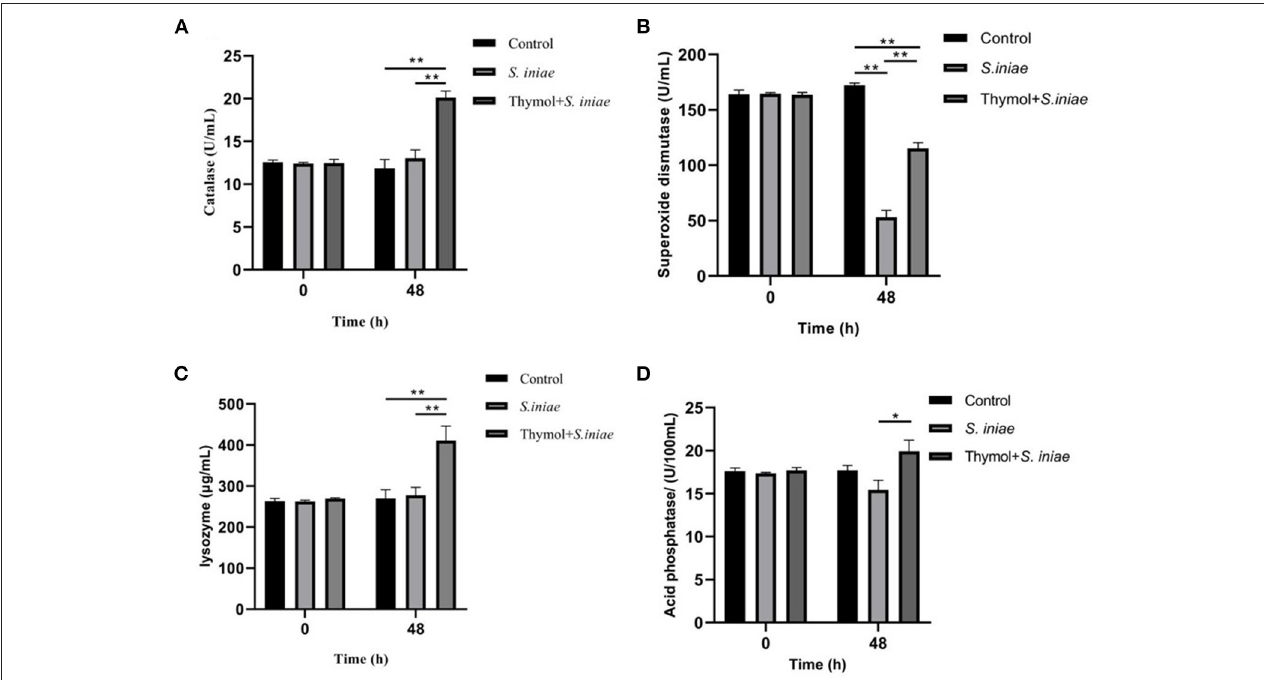
FIGURE 12 | Effects of thymol on serum non-specific immune indicators in channel catfish. (A) CAT activities; (B) SOD activities; (C) LZM activities; (D) ACP activities. And all experiments were repeated three times and the results were expressed as mean ± SD. The symbol ** represents an extremely significant difference ( P < 0.01); the symbol * represents a significant difference ( P <